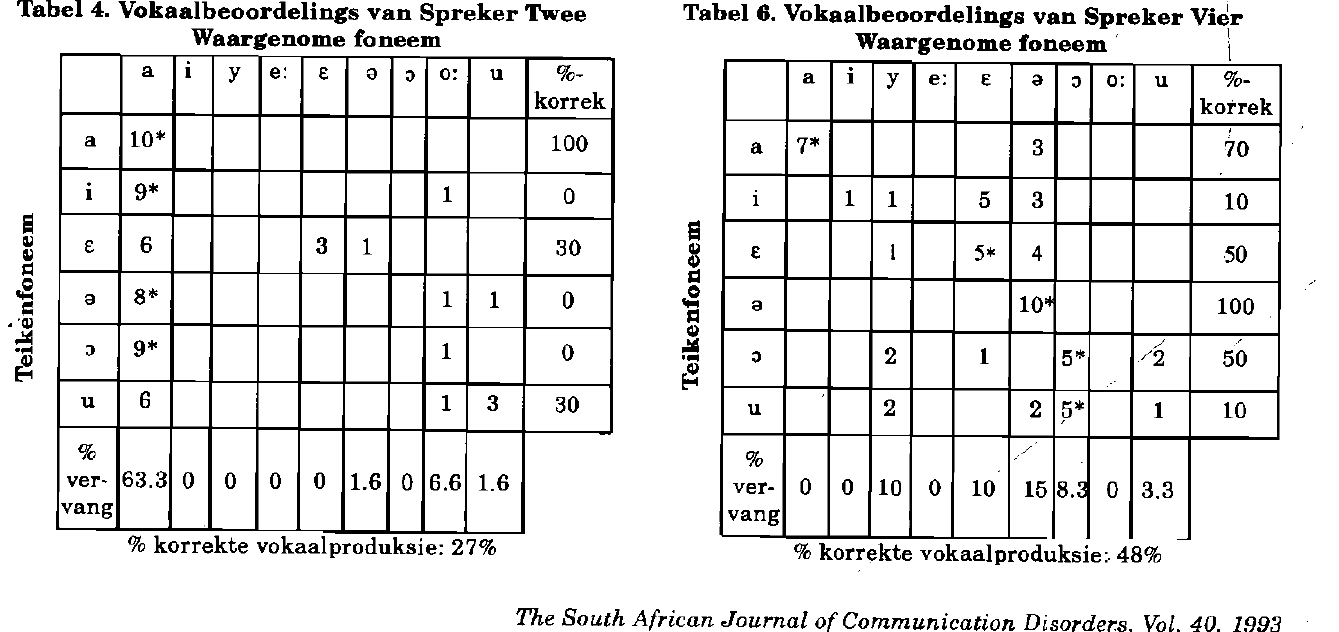
Tabel 6. Vokaalbeoordelings van Spreker Vier Waargenome foneem